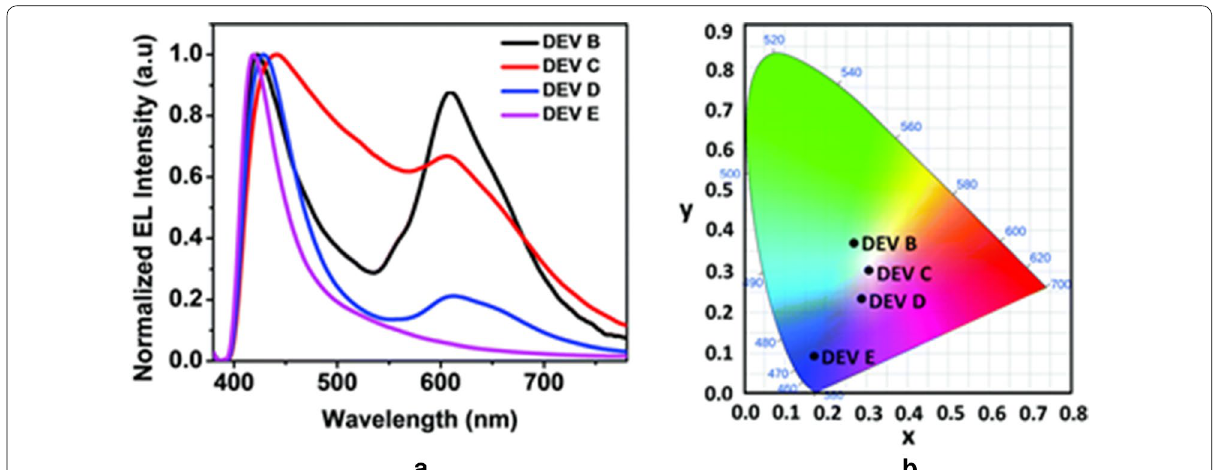
Fig. 9 a The EL spectra and b the CIE co-ordinates diagram of the undoped PVK based PLEDs with or without different ETLs (DEV B-without ETL, DEV B-BCP, DEV B-Bphen and DEV B-TPBi) (Reproduced with permission from Ref. [27] Copyright 2016, ©Physical Chemistry Chemical